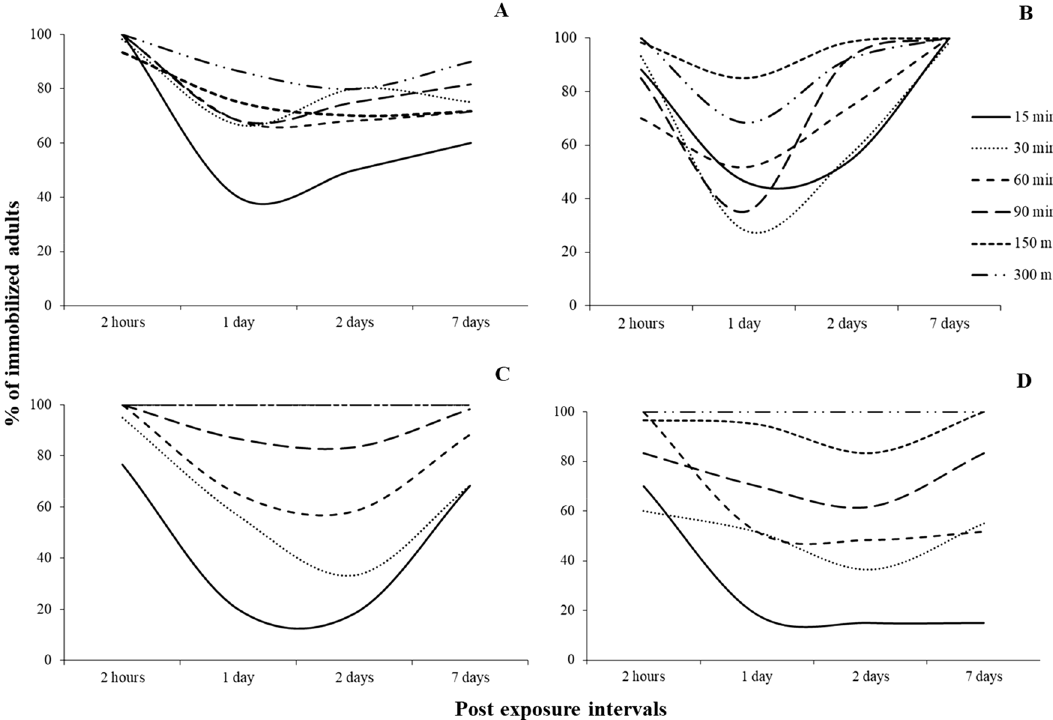
Figure 2. Percentage (%) of immobilized adults of laboratory populations of R. dominica ( A ), S. oryzae ( B ), O. surinamensis ( C ) and T. castaneum ( D ), for each exposure interval (15, 30, 60, 90, 150 and 300 min) after exposure to phosphine at 3000 ppm for different post exposure intervals (2 h, 1, 2 and 7 days). The equations for each exposure interval for each species are presented in Table